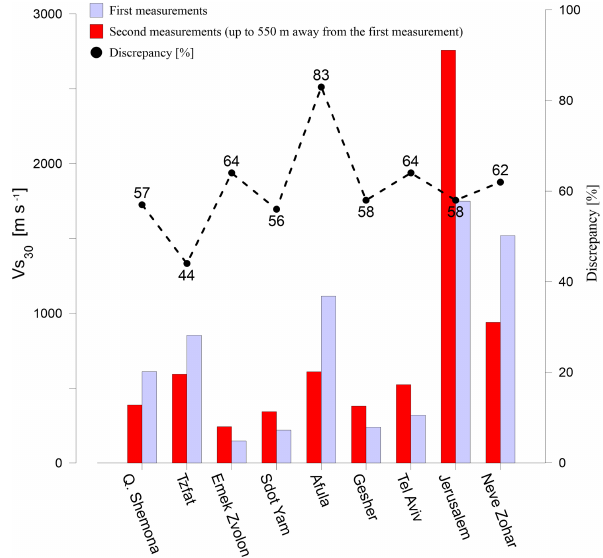
results (light blue) and 30